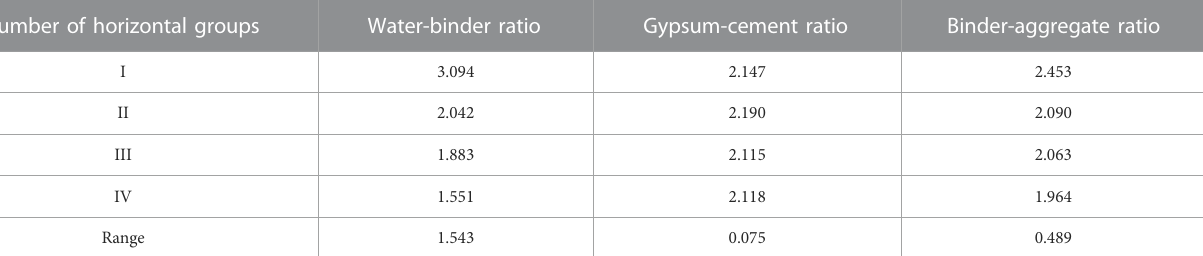
TABLE 6 Analysis of extreme differences in tensile strength (unit: MPa).